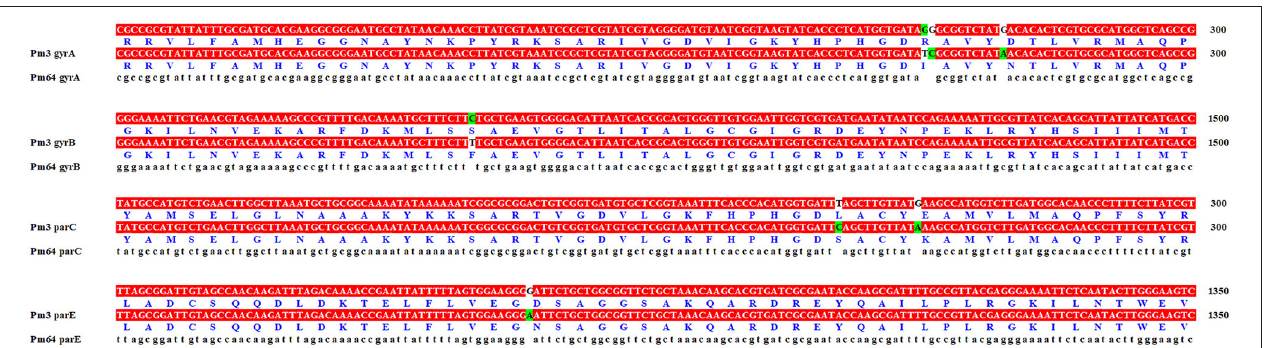
FIGURE 4 | Quinolone resistance determining region (QRDR) comparison of Pm3 and Pm64. Only part of the base mutations sequence (labeled in green) was shown.